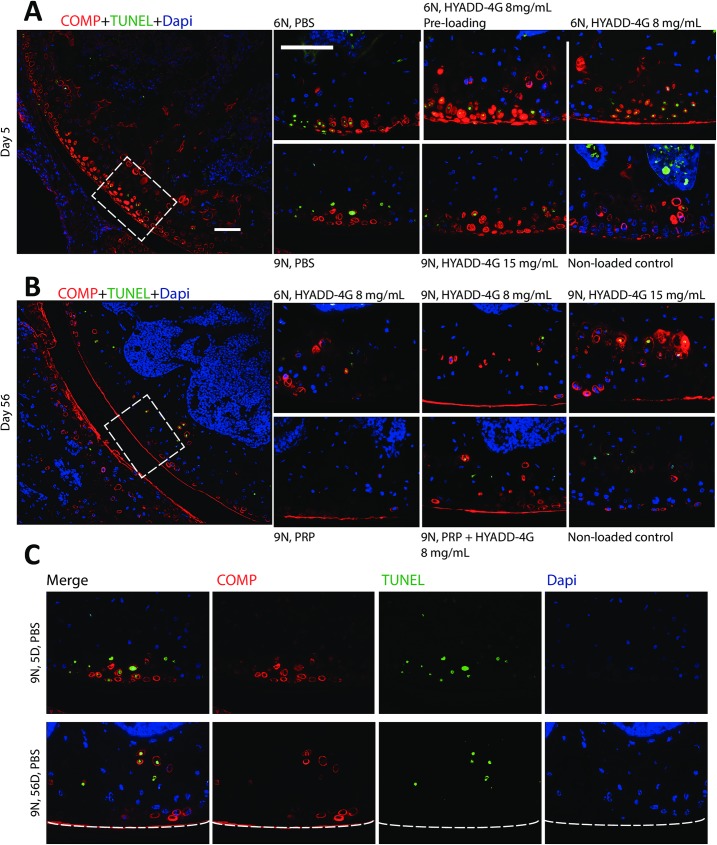
Chondrocyte apoptosis and COMP staining.Representative images of chondrocyte apoptosis (green), COMP (red) and DAPI (blue) immunostaining are shown. At day 5 (A), TUNEL assay identified apoptotic chondrocytes (green) in the injured cartilage area in all loaded groups. COMP (red) was found around the chondrocytes in the intact area and in the lacuna left by the apoptotic chondrocytes in the injured area. At day 56 (B), TUNEL positive chondrocytes in the non-calcified layer of injured cartilage disappeared. No new developed apoptosis was observed. COMP (red) was hardly seen in the injured region and its expression remained the same as day 5 in the adjacent healthy cartilage surface. None of the treatments conferred any protective response on chondrocyte apoptosis or the expression pattern of COMP at day 5 (A) and 56 (B) after loading. White boxes indicate the injured area where enlarged images were taken. Representative images at days 5 and 56 for 9N loading with split channels to show the changes of chondrocyte apoptosis (TUNEL positive cells) and distribution of COMP (red) are also presented (C). Bar = 100 μm, dotted white lines indicate the joint surface. COMP = cartilage oligomeric matrix protein, PBS = phosphate buffered saline, PRP = platelet-rich plasma, TUNEL = terminal deoxynucleotidyltransferase-mediated dUTP nick-end labeling.